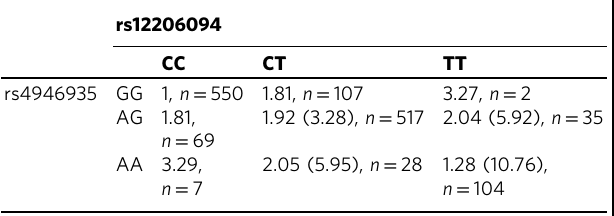
Table 2 Odds ratios of the combined genotypes of rs12206094 and rs4946935